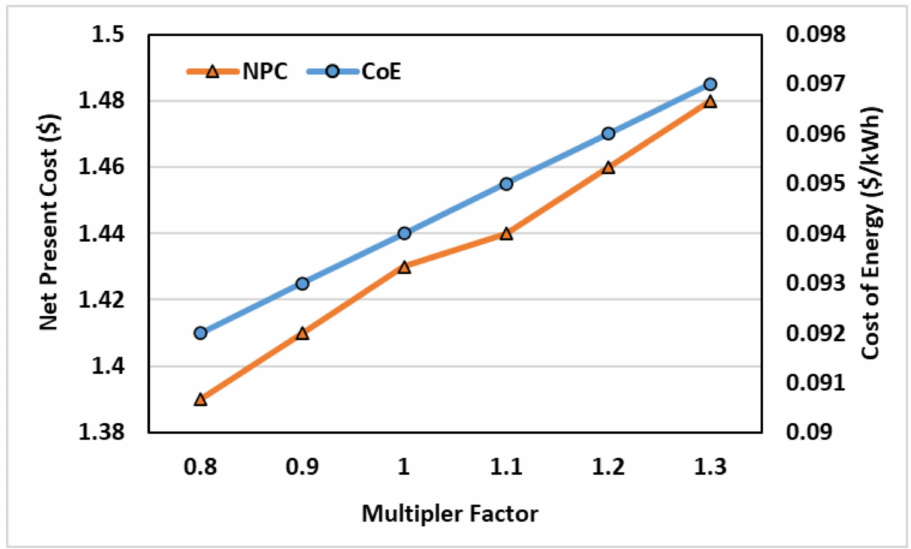
Figure 12. NPC and CoE of HRES with variations in wind turbine